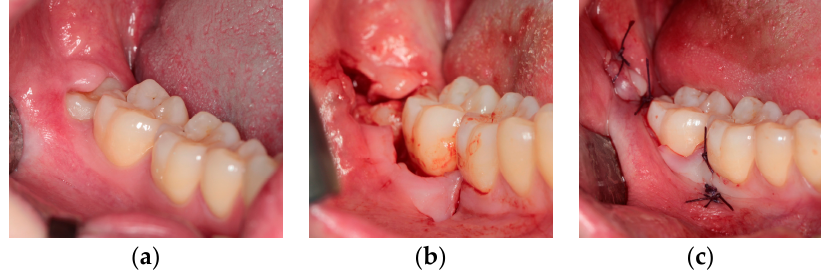
Figure 1. Trapezoidal flap: ( a ) pre-operative clinical view; ( b ) intra-operative incisions; ( c ) final suture.